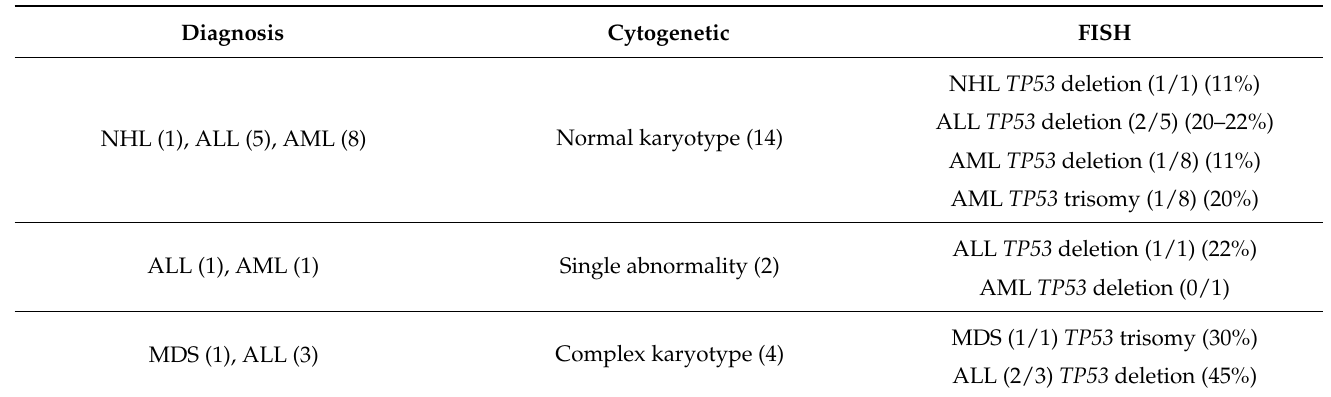
Table 3. FISH result in relation with the clinical diagnosis and cytogenetic